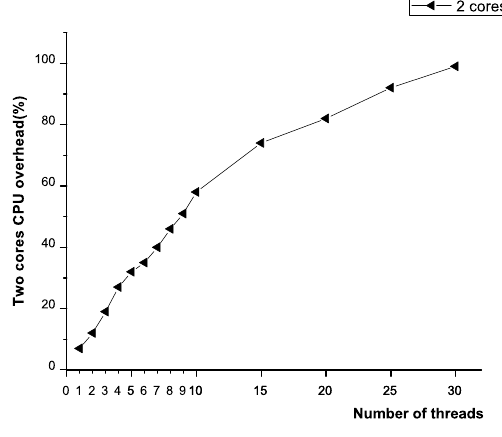
Figure 9. CPU variation with the number of